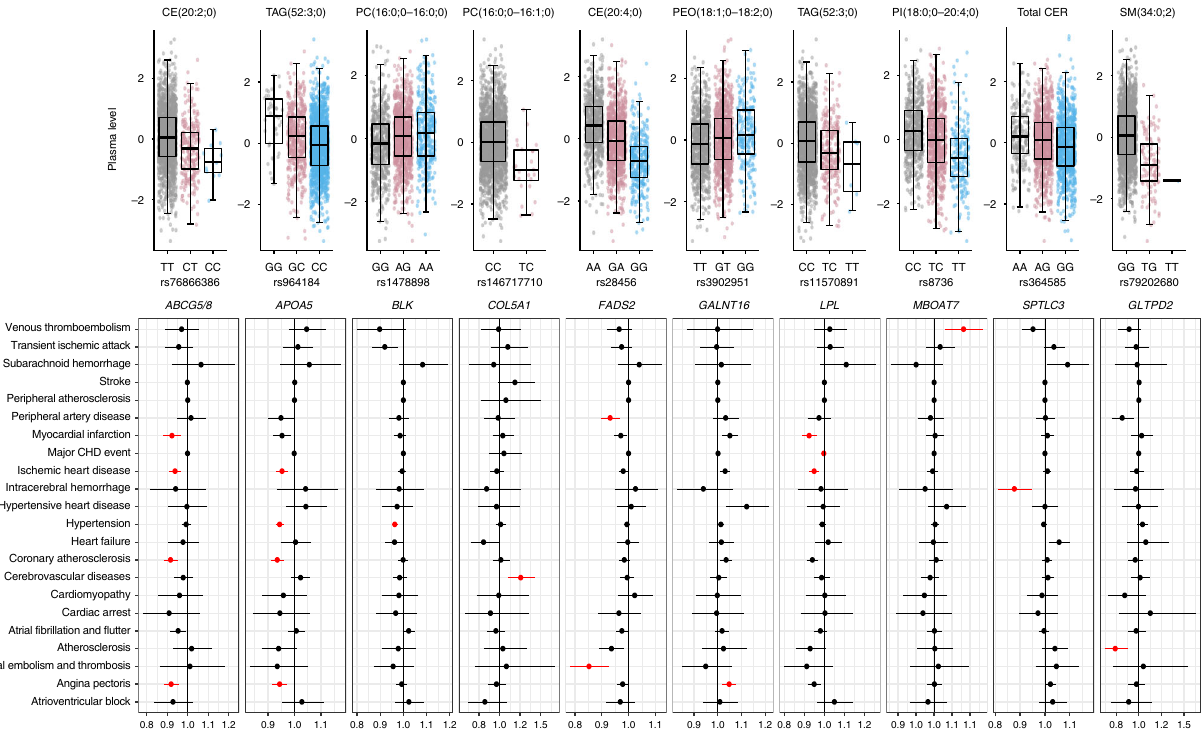
Fig. 5 Relationship between lipid species-associated variants and risk of CVDs. The upper panel shows the association of the identi fi ed variants with the strongest associated lipid species. Boxplots show the interquartile range (IQR) de fi ned by the bounds of the box with the median (middle line of the box) of plasma levels of the respective lipid species for each genotype of the variants; whiskers extend to the largest/smallest values no further than 1.5 times the IQR. The lower panel depicts the relationship between the identi fi ed variants with CVD phenotypes. The effect sizes (odds ratio) with 95% con fi dence interval are plotted with respect to the alternate alleles. The associations with CVD phenotypes highlighted in red colour are signi fi cant at FDR